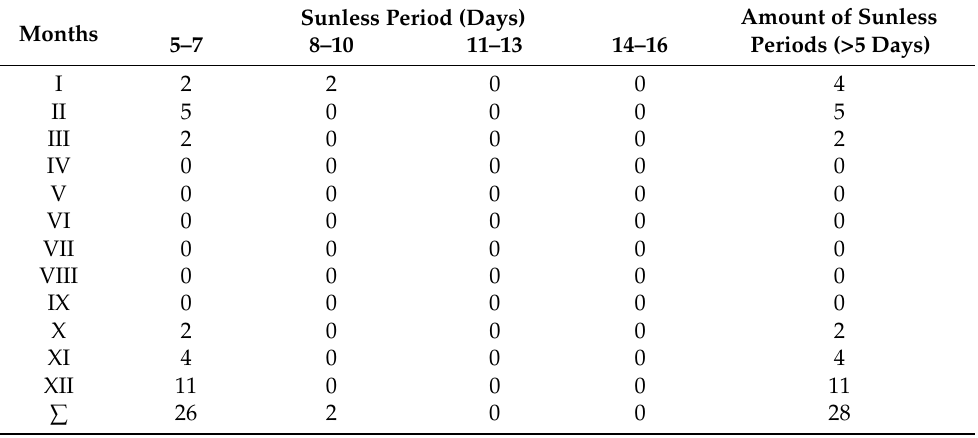
Table 2. The number of compact sunless periods of at least 5 days in Cieplice in the years